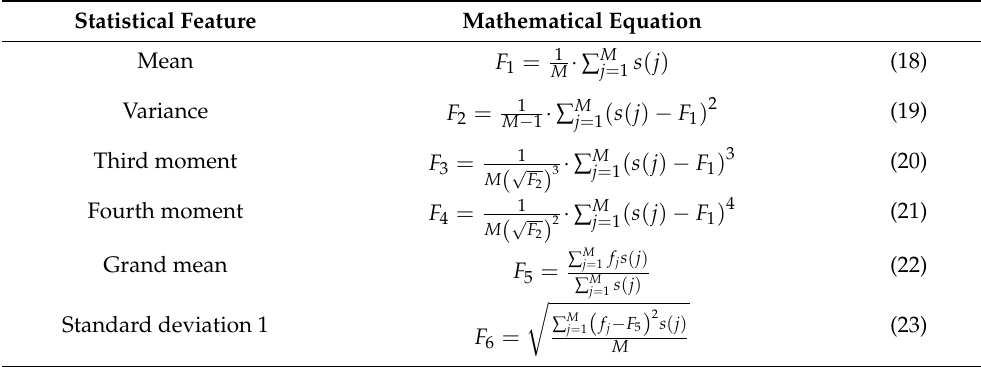
Table 2. The proposed set of statistical features for the characterization of frequency spectra estimated from each available signal during its processing in the frequency-domain analysis, where s(k) is a spectrum for j = 1, 2, . . . , M , and M is the number of lines with f j as the frequency value of the j th spectrum